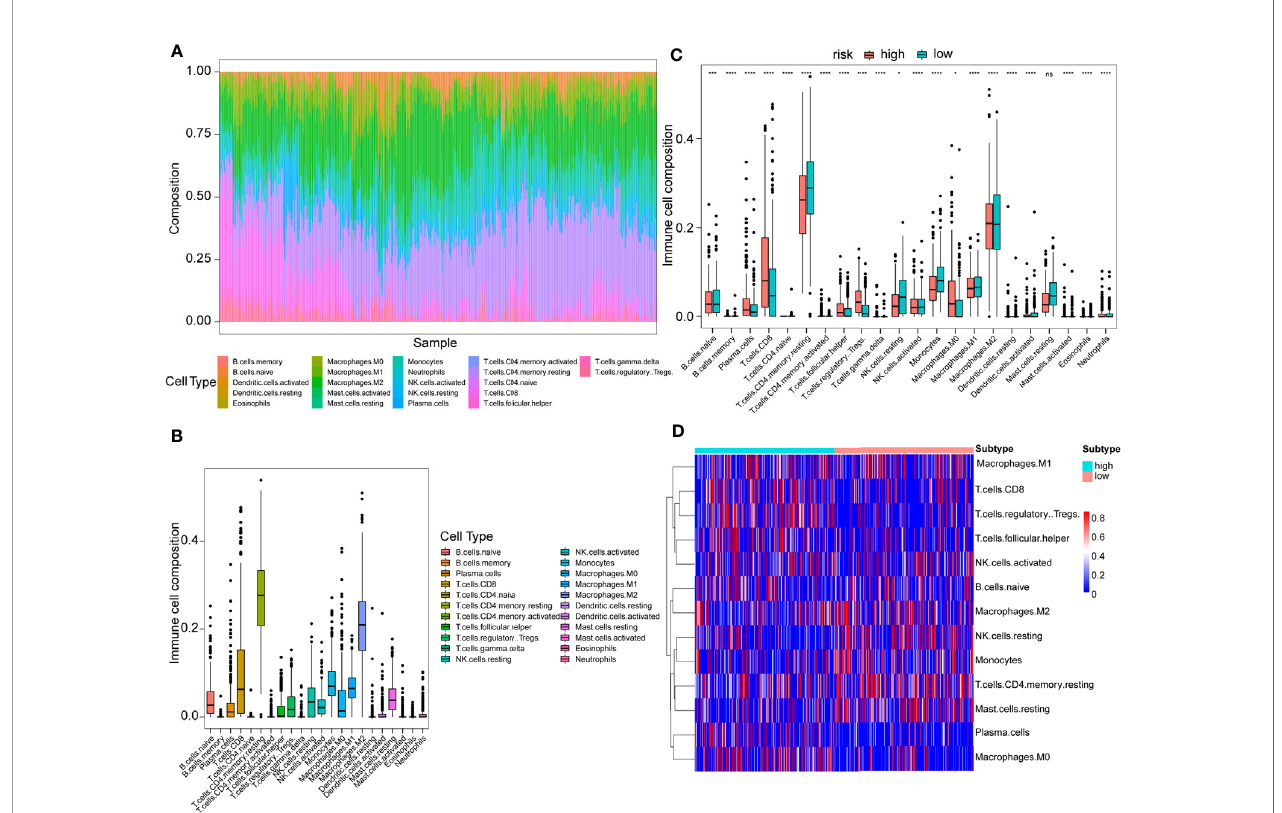
FIGURE 7 | Immune cell proportion analyses in the TCGA cohort between high- and low-risk score patients. (A) Overall view of relative proportions of immune cell in fi ltrations for 22 immune signatures. (B) Boxplots for 22 immune cell proportions in the TCGA cohort. (C) Boxplots for different immune cell in fi ltrations in the high- and low-risk score patients. Signi fi cance: ns ≥ 0.05, ∗ <0.05, ∗∗∗ <0.001, and ∗∗∗∗ <0.0001. (D) Immune cell heatmap for patients in the high- and low-risk score subtypes. Only immune cells whose non-zero proportions exceeded half in all samples were